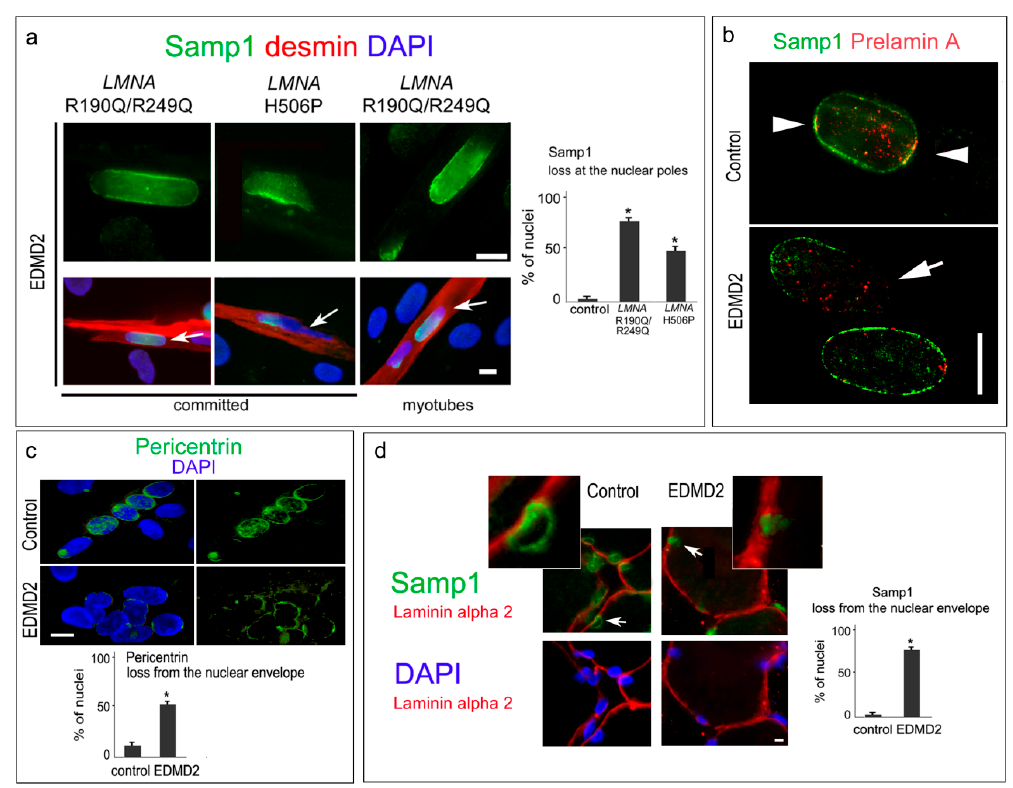
Figure 4. Mis-localization of Samp1 in the EDMD2 nuclei. ( a ) Samp1 staining in EDMD2 myoblasts committed to differentiation (committed) and myotubes (myotubes). Myotubes are double stained for desmin (red). Upper panel, high magnification of nuclei indicated by arrows. The percentage of nuclei showing Samp1 loss at the nuclear poles (at least one pole) is reported in the graph. ( b ) Double staining of prelamin A and Samp1 in differentiated control and EDMD2 myoblasts. Arrowheads indicate co-localization, the arrow indicates a nuclear pole devoid of Samp1 and prelamin A fluorescence. ( c ) Pericentrin staining in the control and the EDMD2 myotubes. Percentage of nuclei showing pericentrin loss at the nuclear periphery (negative nuclei) is reported in the graph. ( d ) Samp1 and laminin alpha 2 were co-stained in muscle tissue from control (control) and EDMD2 (EDMD2). Nuclei inside the basal lamina outlined by laminin alpha 2 are myonuclei. Percentage of nuclei showing Samp1 loss from the nuclear envelope is reported in the graph. Magnification of selected nuclei (arrows) is shown in the insets. Nuclei in ( a,c,d ) are counterstained with DAPI. Statistically significant differences by the Mann Whitney test are indicated by asterisks (*). Scale of bars, 10 µm.